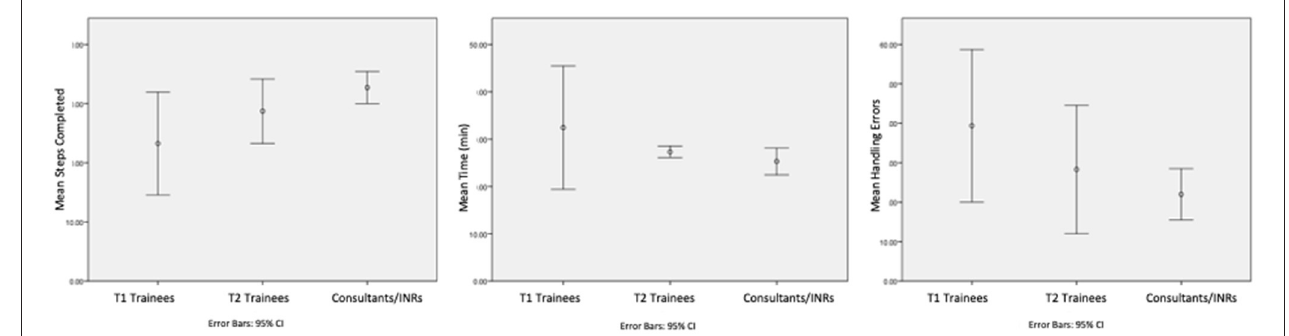
FIGURE 3 | T1 represents trainees at baseline, T2 represents trainees after the course and Consultants/INRs represent the proficiency benchmark. The performance of the trainees in terms of number of procedure steps completed, procedure time and handling errors all improved, but none of them reached the proficiency in the given time of the